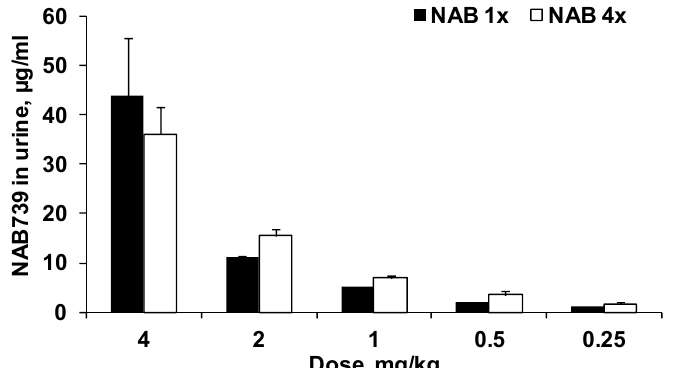
Figure 4. Concentrations of NAB739 in NMRI mice urine after the first and the last SC administration at doses of 0.25–4 mg/kg. Data expressed as average ± SEM from four NMRI mice.